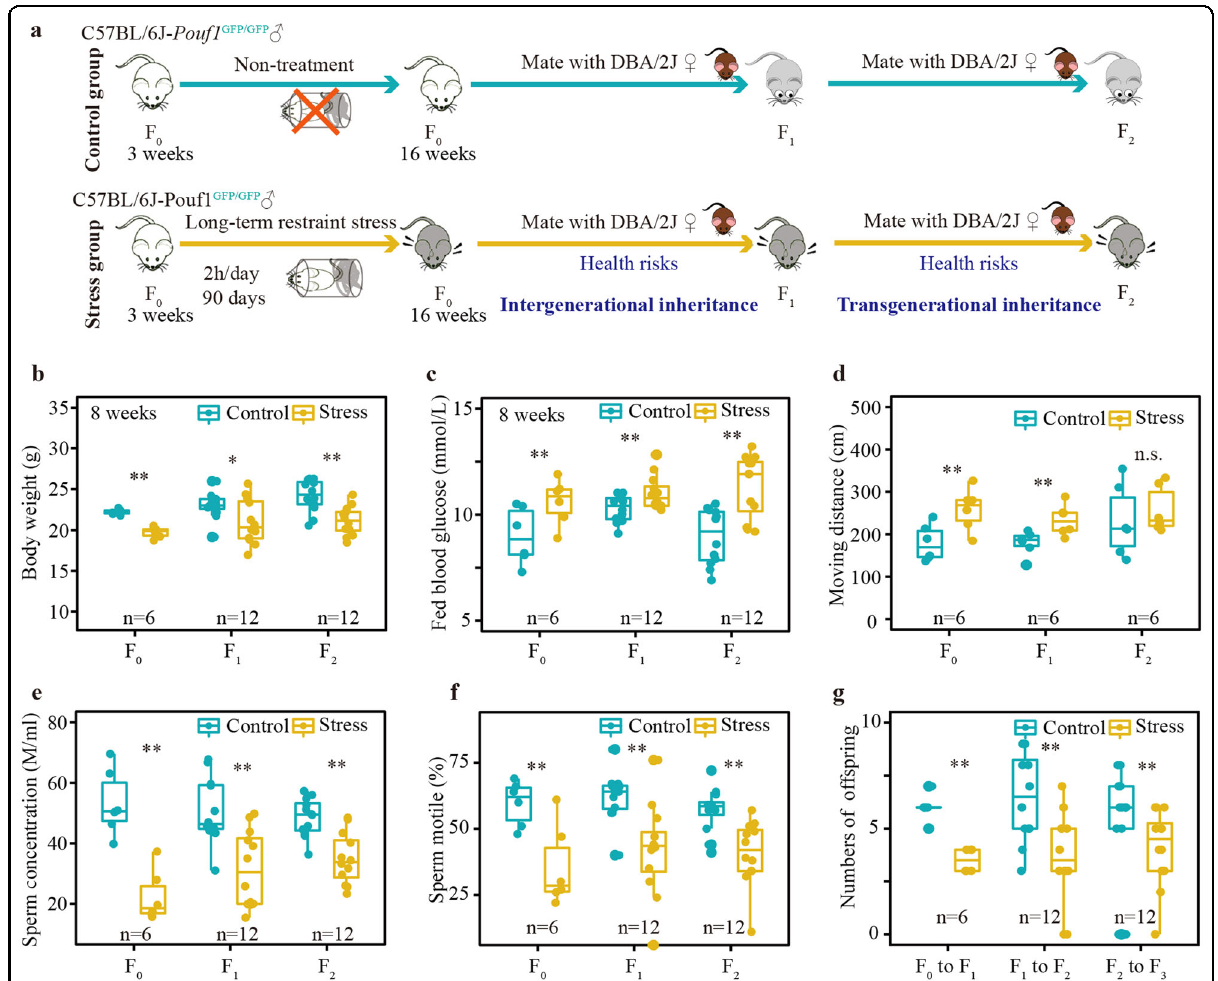
Fig. 1 Long-term psychological stress induces paternal inheritance of health risks in offspring. a Chronic restraint stress mouse model construction. b Stress-induced transgenerational inheritance of developmental retardation. c Stress-induced transgenerational inheritance of disorder in blood glucose metabolism. d Elevated plus maze (EPM) test to assess anxiety-like behavior in mice. Stress-induced intergenerational inheritance of higher risk-taking behavior and overall physical activity. e Stress-induced transgenerational inheritance of decline in sperm concentration decline. f Stress-induced transgenerational inheritance of reduced in sperm motility. g Stress-induced transgenerational inheritance of reduced in fertility rate. * t -test p -value < 0.05; ** t -test p -value < 0.01; n.s. no signi fi cant, t -test p -value >